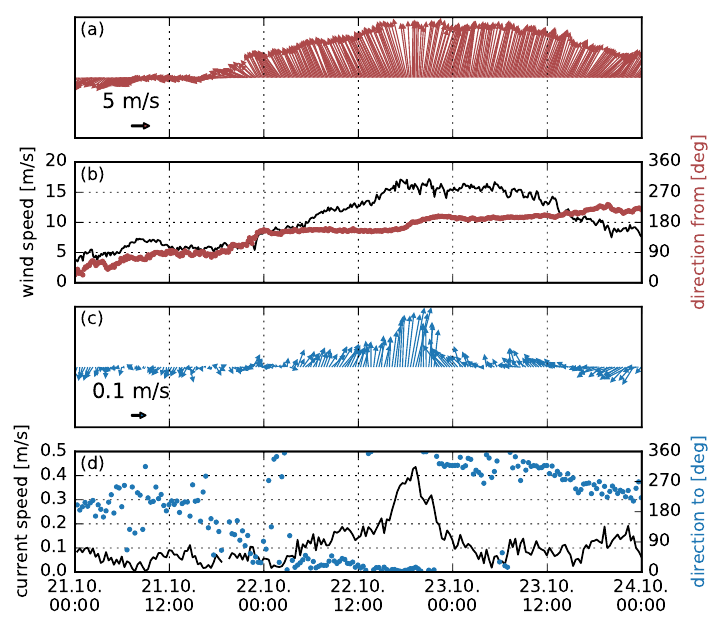
Figure 8. Wind speed and direction at Utö AWS ( a , b ) with current speed and direction at Lövskär crossing ( c , d ) during 21–24 October 2013. Locations of the measurement stations shown in Figure 1.